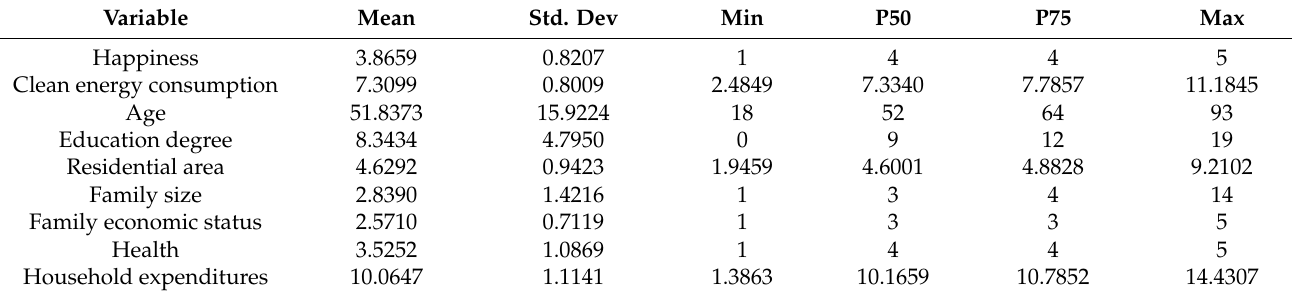
Table 3. Descriptive statistics of other